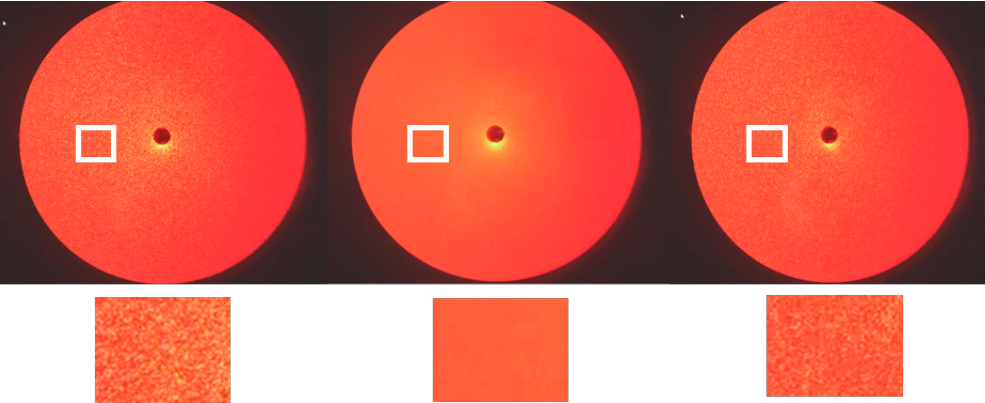
Figure 12: Untreated UT GCC in hexadecane, 3 w/w% solids, under shear between parallel counter-rotating plates, gap 0.3 mm: left to right low shear under ramp-up, high shear, and low shear under ramp-down. Enlarged images from the rectangular inserts reveal the structural change from remaining static, despite shear, to homogeneous shearing and return to a structured state, despite continuing low shear, respectively.